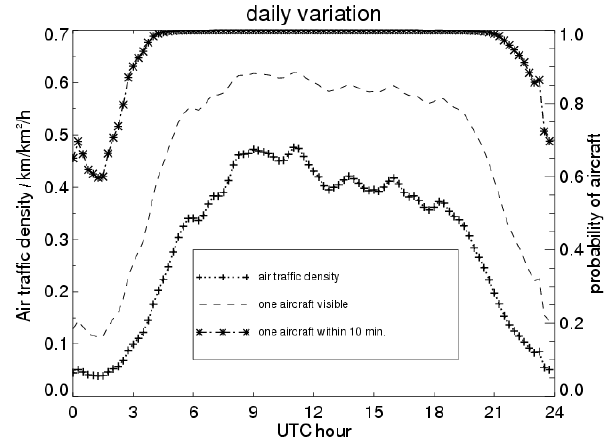
Fig. 5. Daily variation of higher level air traffic density (flown distance per square km and hour) in southern Bavaria according to data from EUROCONTROL for the summer schedule of 2004 ( + ); probability that at least one aircraft is within Wolkam’s field of view (dashed line); probability that at least one aircraft is visible in Wolkam’s field of view within 10min ( ∗